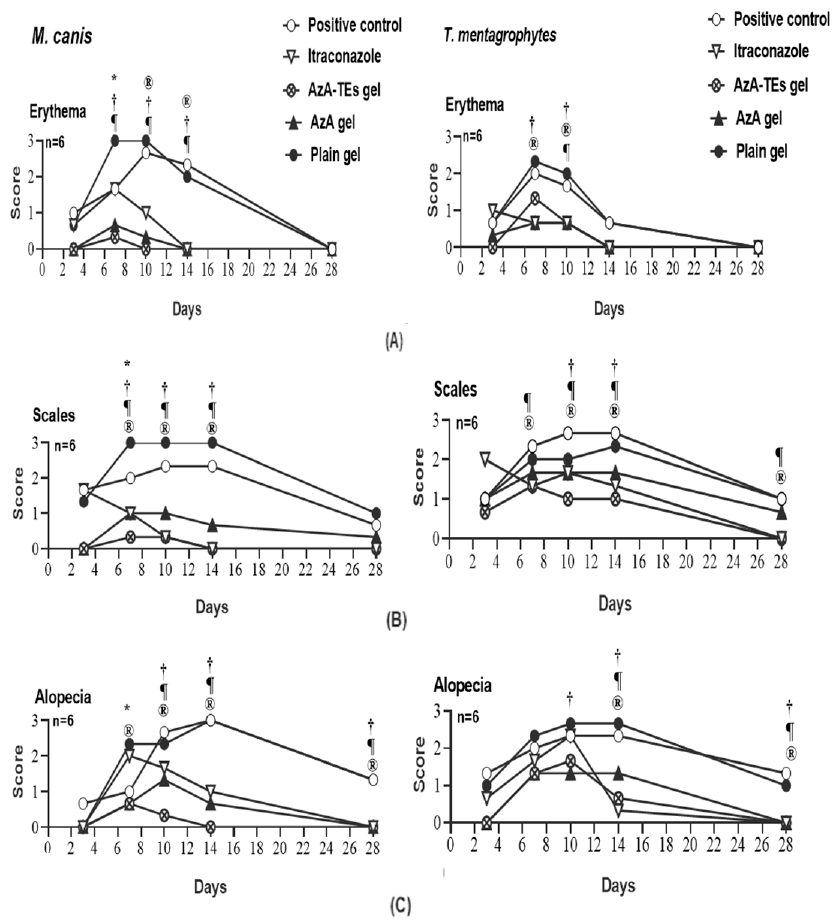
Figure 4. Means of erythema ( A ), scales ( B ), and alopecia ( C ) scores in Microsporum canis and Trichophyton mentagrophytes infected guinea pigs in different groups. * p < 0.05 (plain gel); † p < 0.05 (AZA gel); ® p < 0.05 (itraconazole); ¶ p < 0.05 (AzA-TEs gel) versus untreated positive controls. p -value was estimated using exact Wilcoxon test. Table 5. Mycological evaluation of dermatophytosis treatments in a guinea pig model.